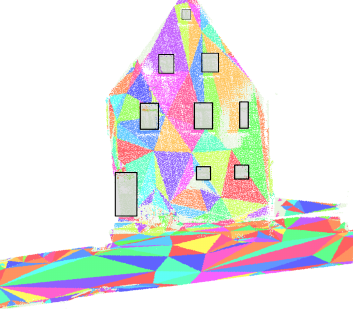
Figure 8. LiDAR points randomly colored by the associated face index. Non-associated points are marked by the black-framed grayish